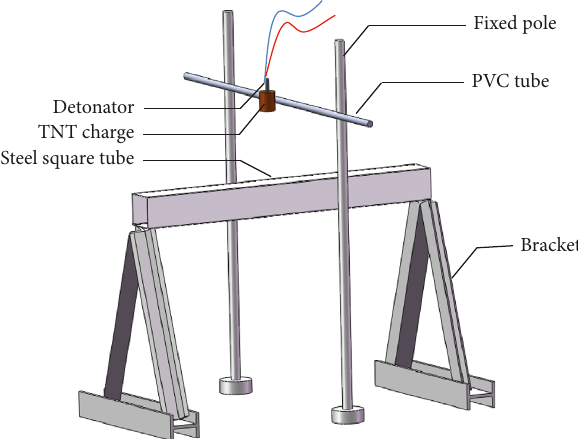
Figure 1: Sketches of experiment